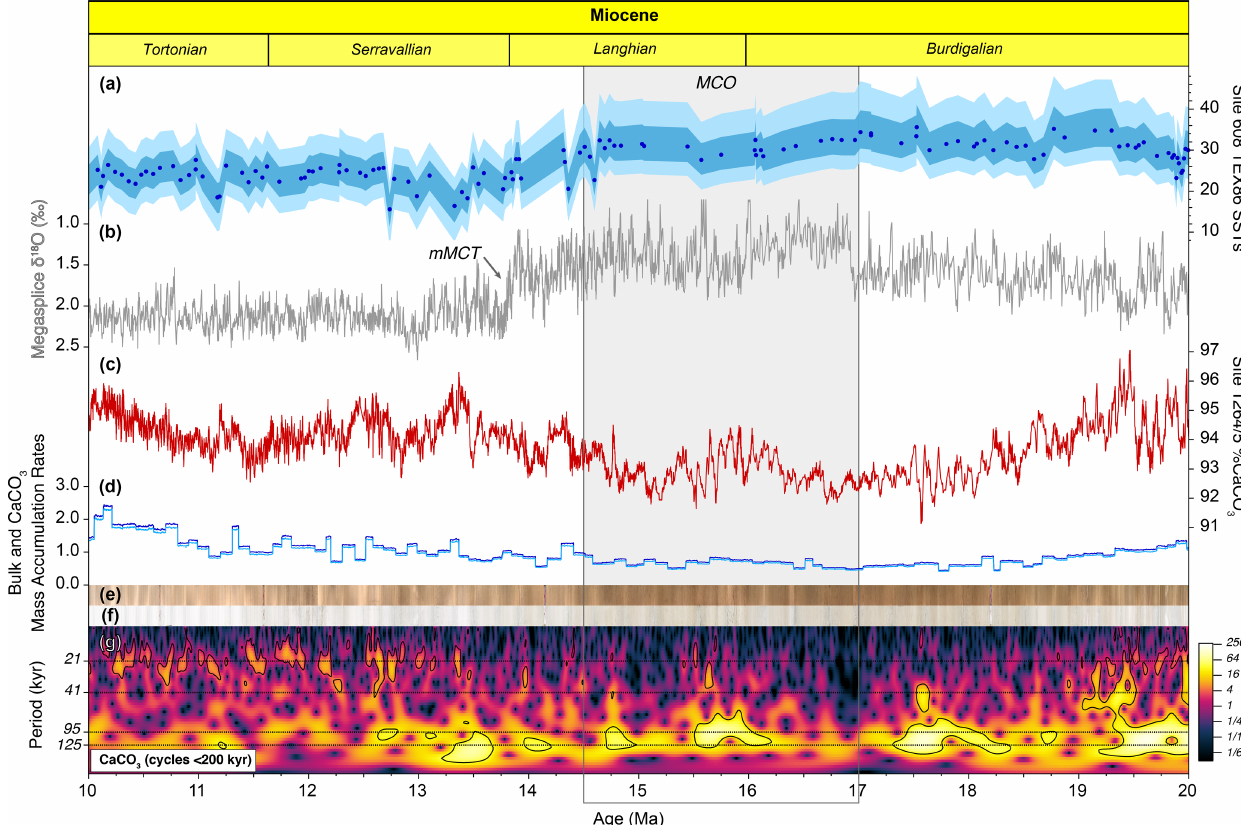
Figure 7. Middle to late Miocene Site 1264–1265 data on the new astrochronology: (a) BAYSPAR TEX 86 SSTs from Site 608 (blue dots are the 50th percentile; medium blue is 65% CL; light blue is 95% CL; Super et al., 2018); (b) benthic δ 18 O Megasplice (De Vleeschouwer et al., 2017); (c) XRF-derived CaCO 3 data from Site 1264–1265; (d) bulk and CaCO 3 MARs for Site 1264–1265 (dark and light blue, respectively); (e) Site 1264–1265 line scan and (f) core box composite core photos; and (g) wavelet spectra in the time domain of the CaCO 3 data detrended to remove cycles > 200kyr (Torrence and Compo, 1998; Grinsted et al., 2004). The approximate location of the MCO and the mMCT are also